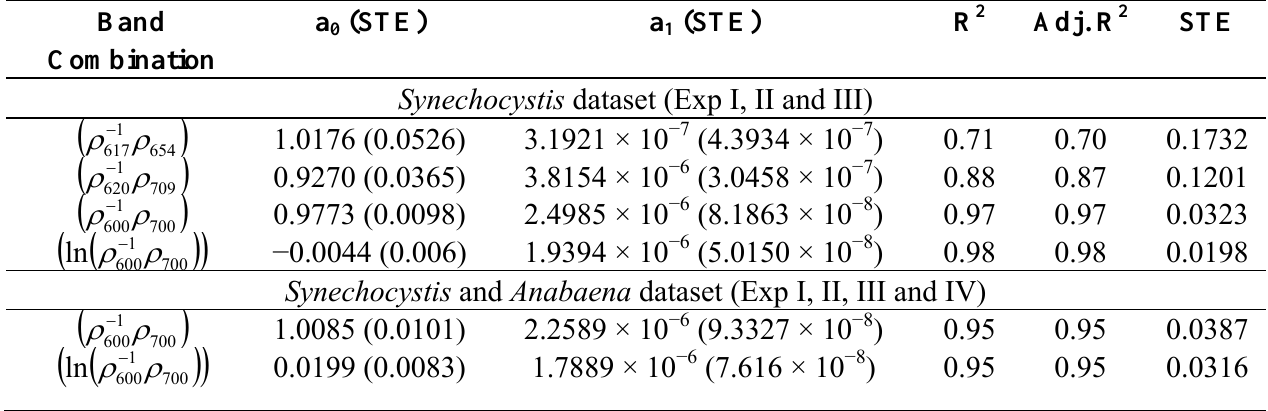
Table 2. Model parameters and performance: Intercept (a corresponding standard error of estimate (STE); coefficient of determination (R 2 ); adjusted coefficient of determination; STE of estimate for linear regression of different models obtained using the calibration dataset.